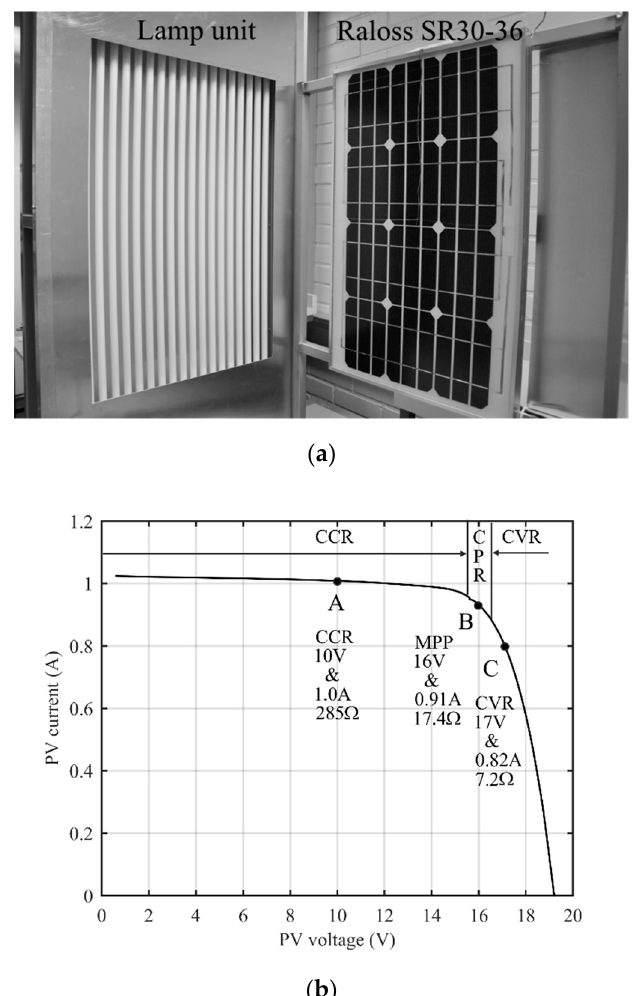
Figure 9. Raloss PVG: ( a ) Its construction and ( b ) authentic PV curve with the operating points A, B, and